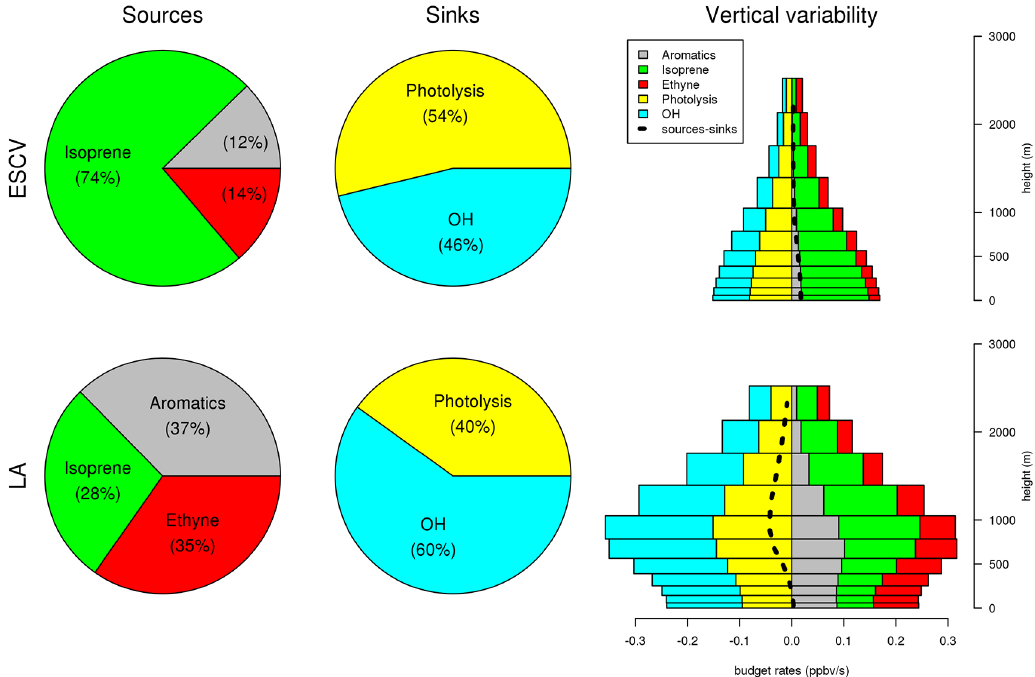
Figure 8. Relative importance of different photochemical sources and sinks of glyoxal in the LA basin and eastern slopes of the Central Valley focus region as time average over the simulation period in the lowest model level (pies), and its vertical variability (bar plot). Direct emissions of glyoxal were found to be minor (<0.1%) and are not included in the plots. Results shown are from the BASE simulation where glyoxal does not interact with